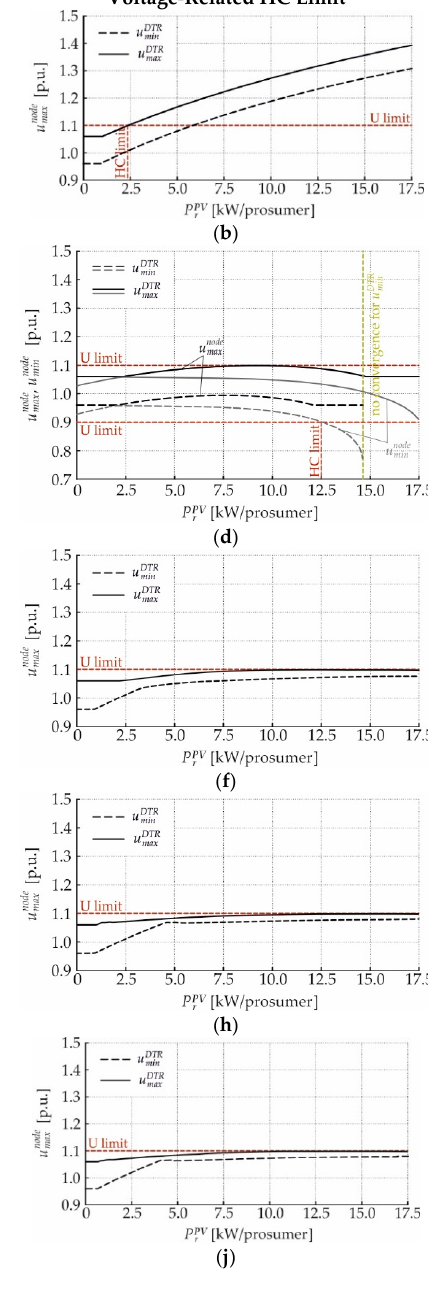
Figure 7. Current- and voltage-related hosting capacity limits of the long overhead line test-feeder for di ff erent control strategies: ( a , b ) no-control; ( c , d ) cos ϕ ( P )-control; ( e , f ) Q ( U )-control; ( g , h ) L ( U )-control; ( i , j ) L ( U )-control and Q -Autarkic